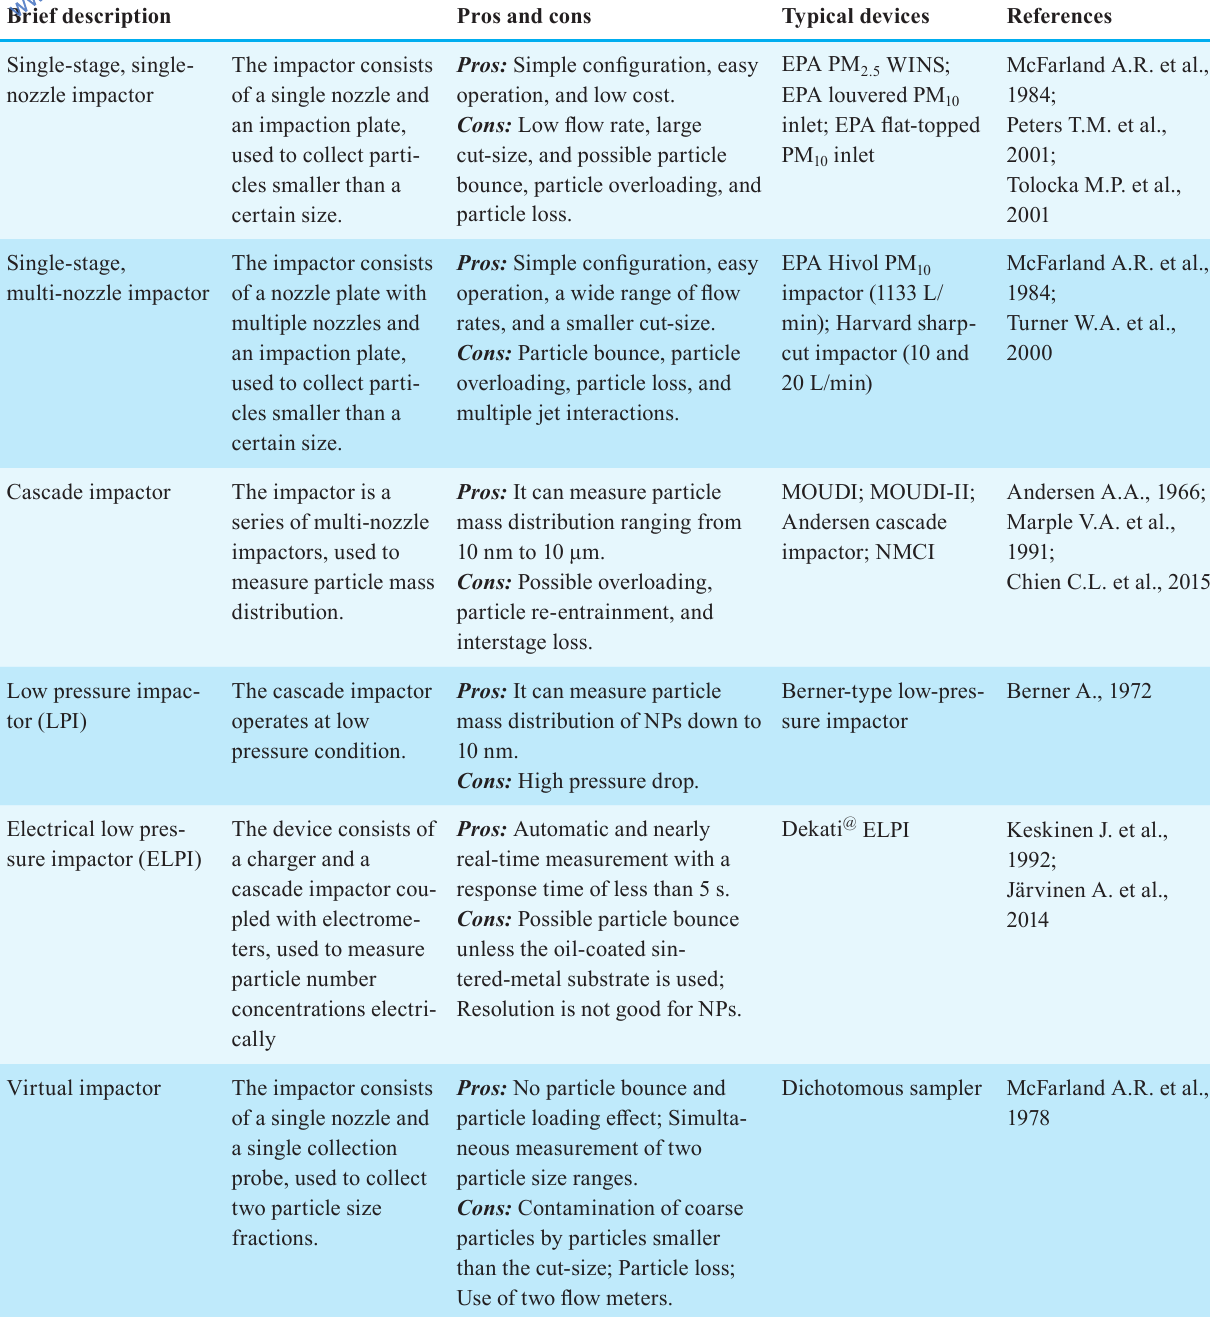
Table 1 Types of inertial